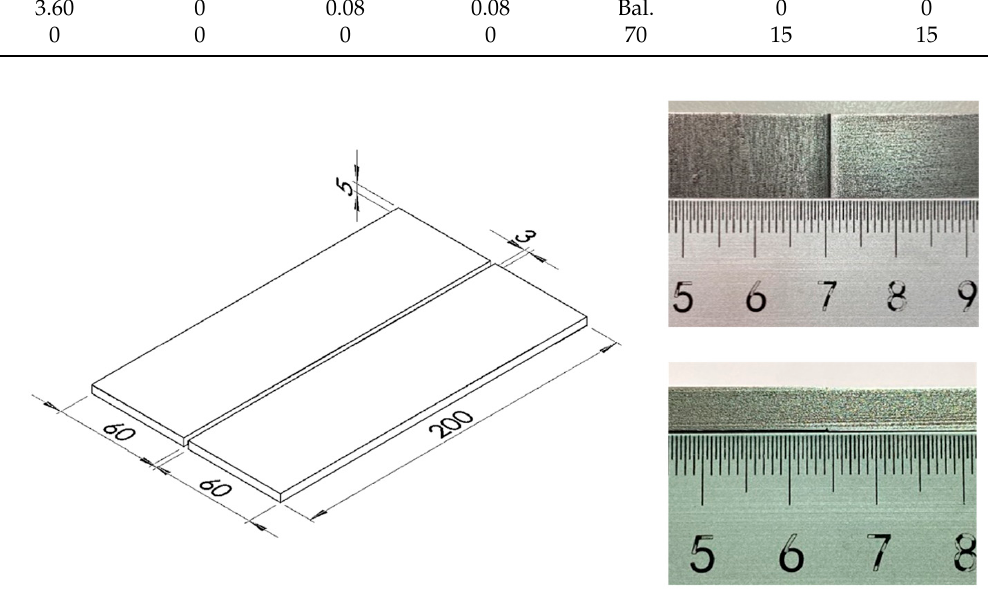
Figure 1. Configuration of the butt joint in vacuum brazing (all dimensions in mm).